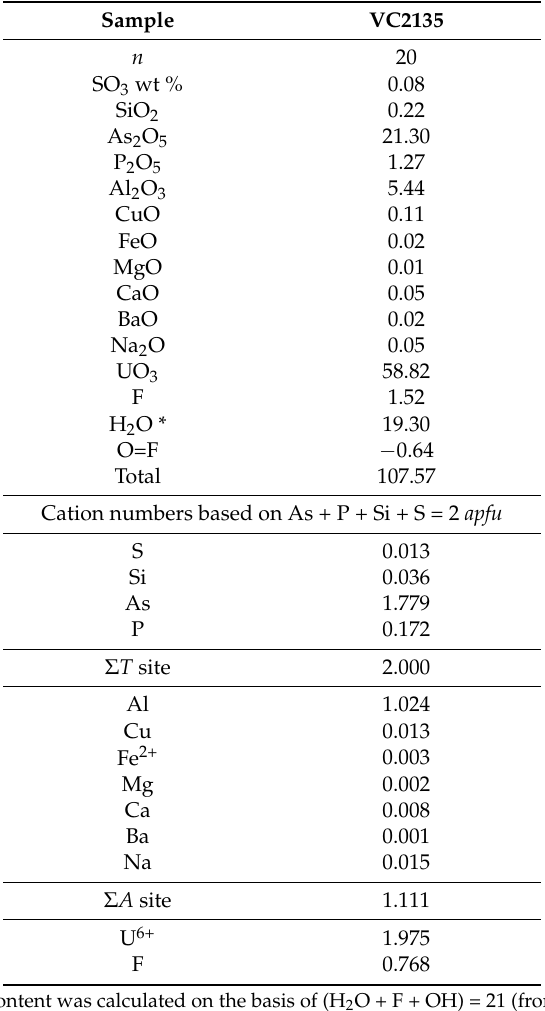
Table 9. Chemical composition of arsenuranospathite.